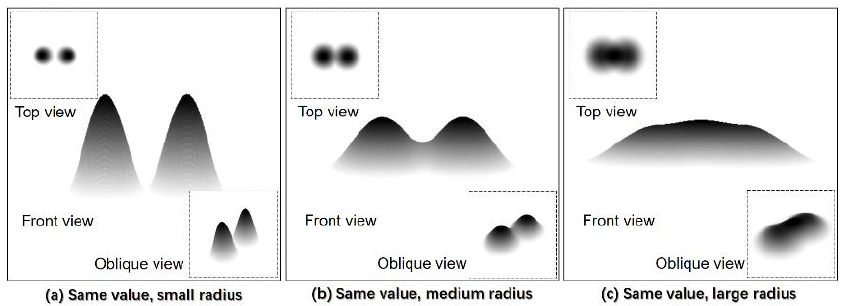
Figure 7. Terrain created by two points with the same target attribute value and different search radii.